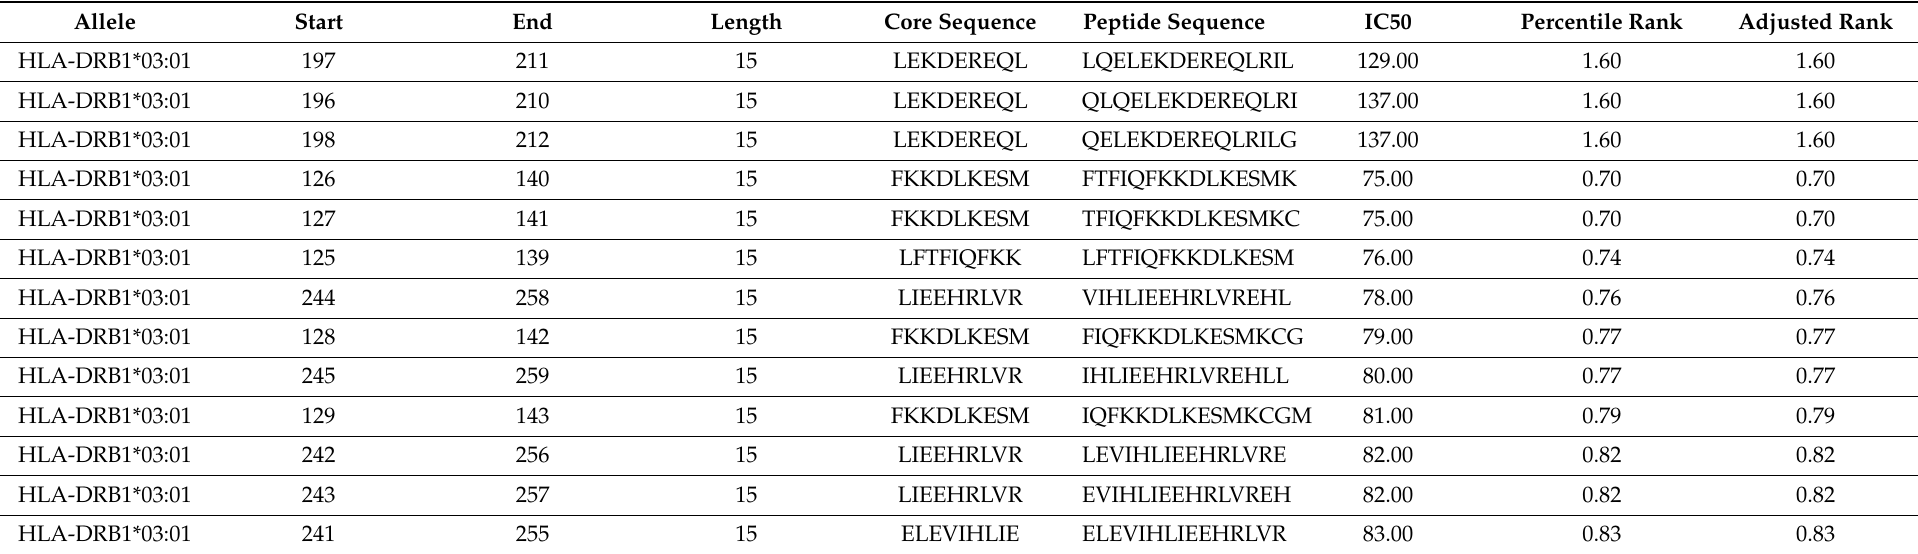
Table 5. HLA-DR3 allele with predicted peptides of human Ro60.